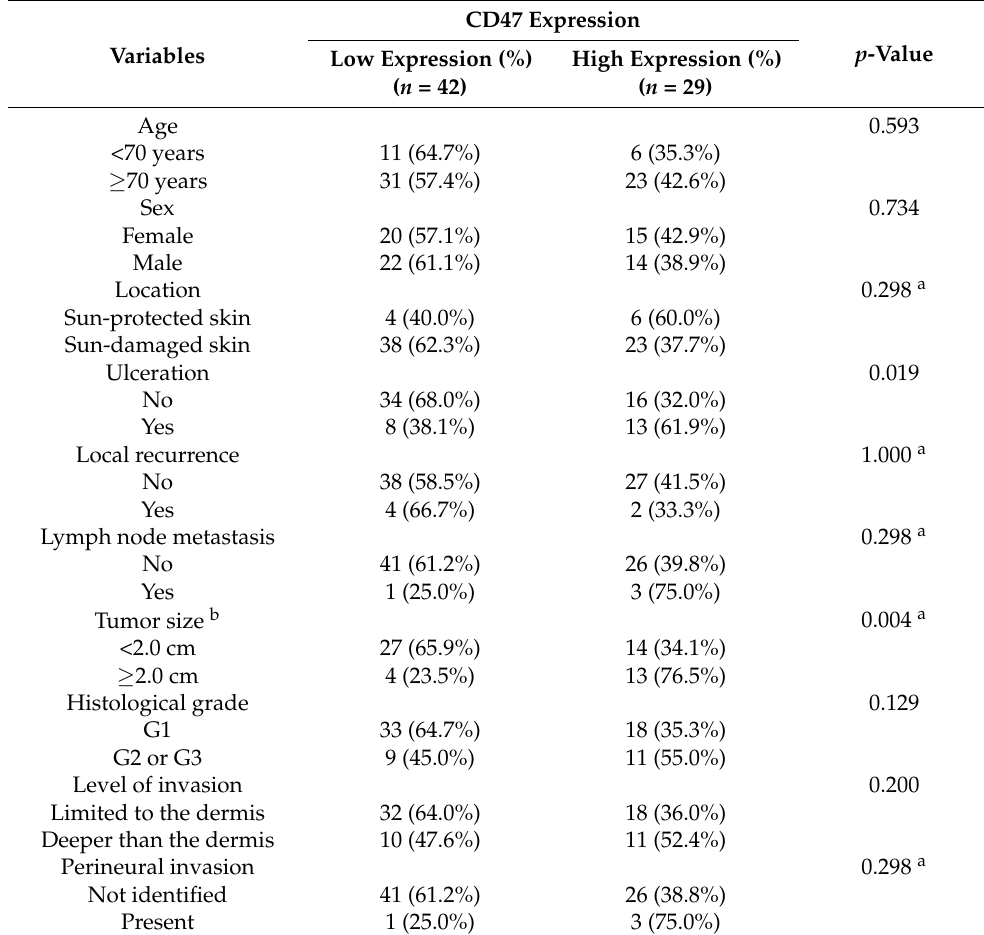
Table 2. Correlations between CD47 expression and clinicopathological characteristics in cases with squamous cell carcinoma ( n =